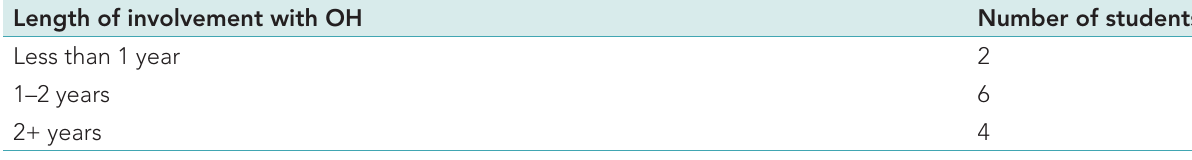
Table 3: Length of student involvement with Our Health (Source: Authors, 2022) Length of involvement with OH